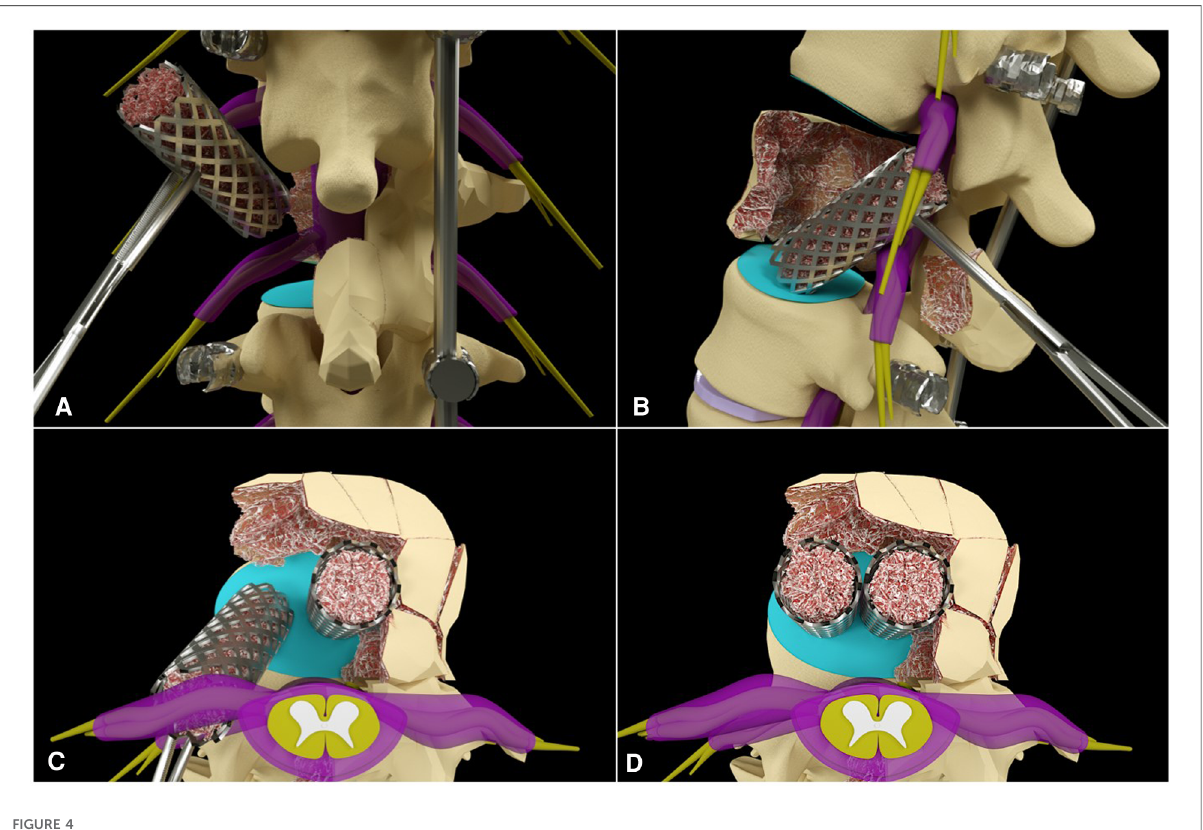
FIGURE 4 The schematic pictures of double TMC